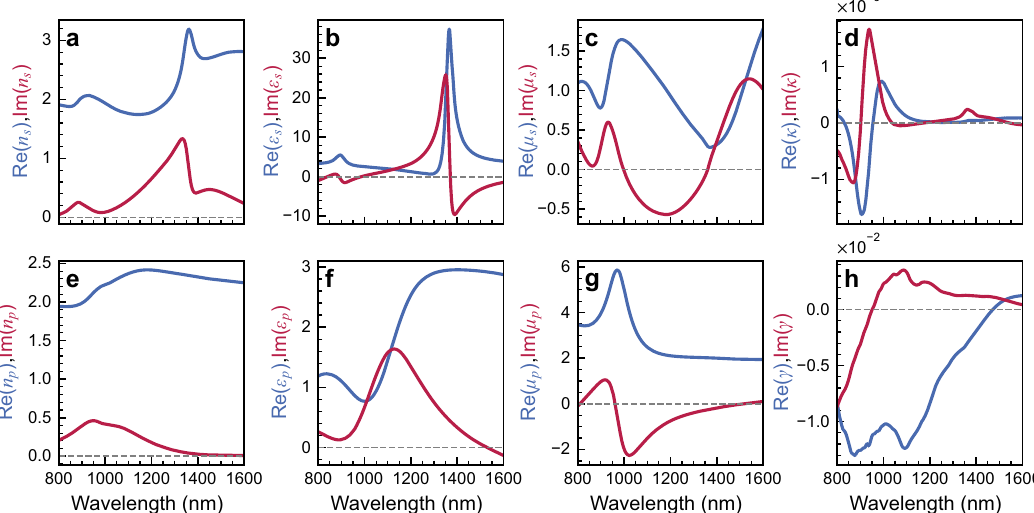
Fig. 5 Gyrotropic permeability and permittivity tensor of the MO-SRR metamaterials. a Effective refractive index of the metamaterial under s-polarization. b Diagonal components of the complex permittivity under s-polarization. c Diagonal components of the complex permeability under s-polarization. d Off-diagonal components of the complex permeability tensor. e Effective refractive index of the metamaterial under p-polarization. f Diagonal components of the complex permittivity under p-polarization. g Diagonal components of the complex permeability under p-polarization. h Off- diagonal components of the complex permittivity